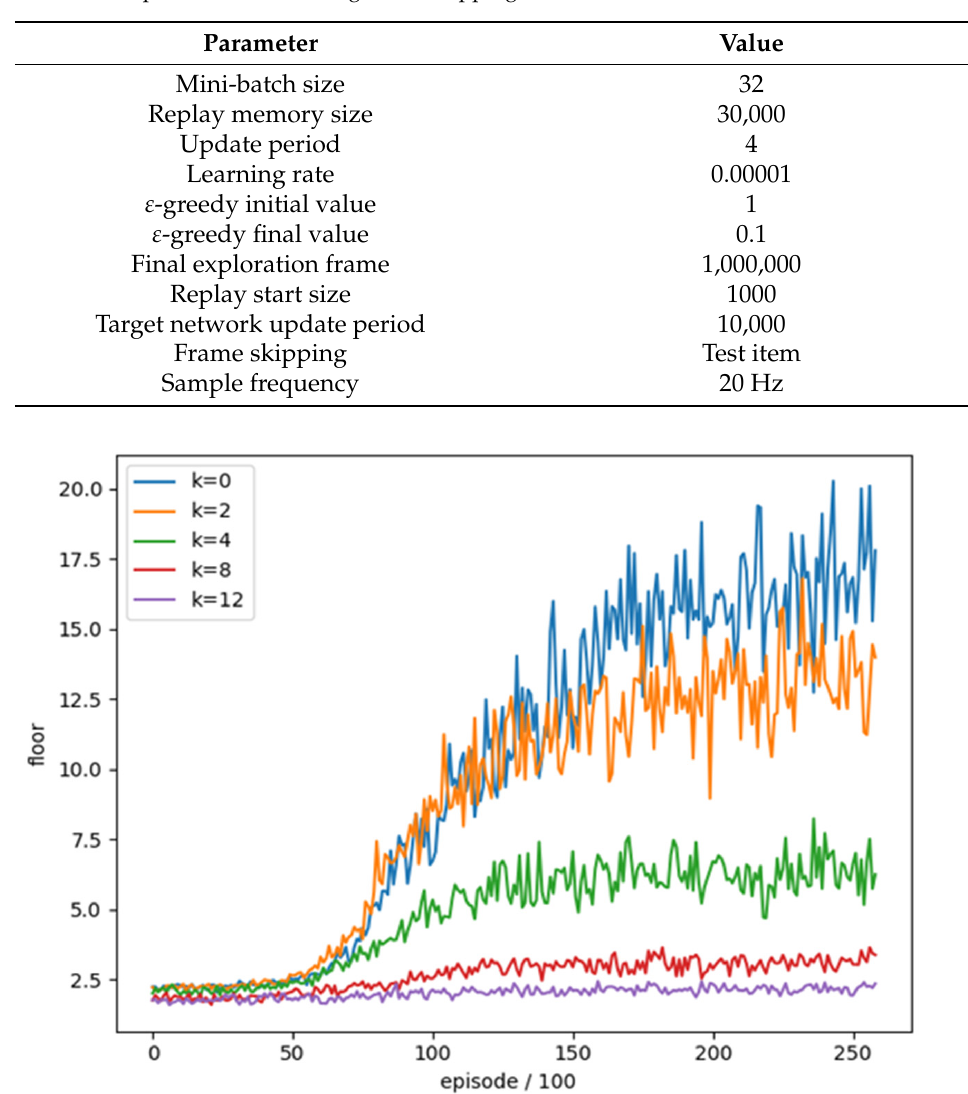
Figure 12. The training trend of frame skipping in different setting.